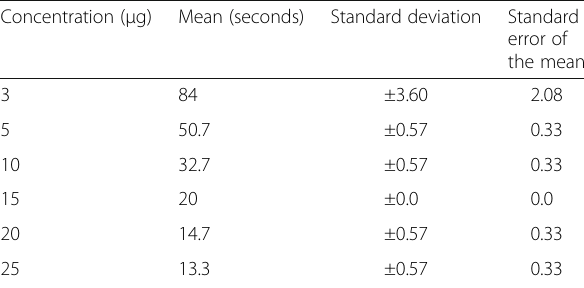
Table 1 Serine protease concentrations employed to evaluate the clotting time, the mean of three measures, the standard deviation and standard error of the mean for a 95% confidence interval at pH